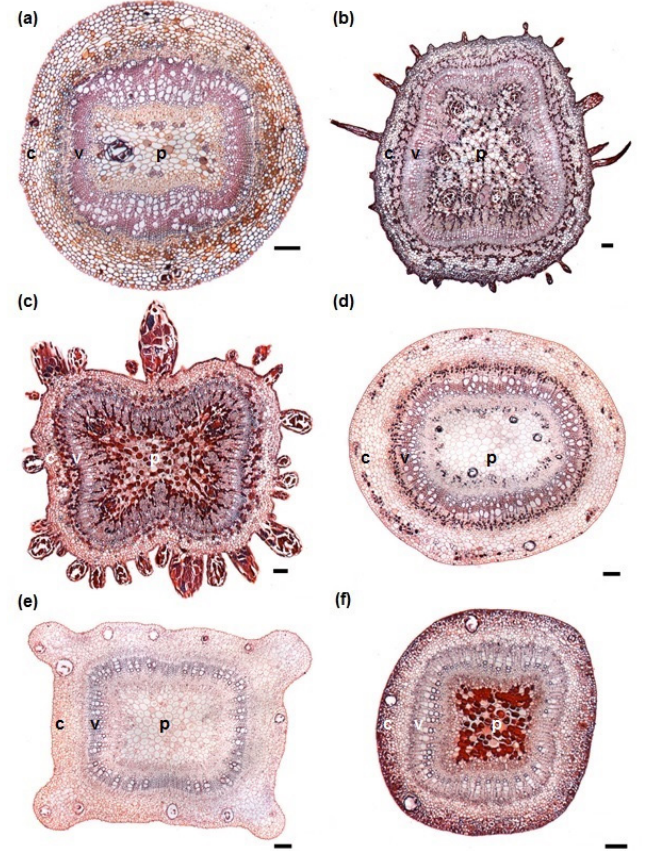
Figure 3. Transverse sections from the stem of cuttings from near the fourth-most apical node (N4) of stock plants of ( a ) Angophora costata , ( b ) Corymbia torelliana , ( c ) C. citriodora , ( d ) Eucalyptus tetrodonta , ( e ) E. microcorys , and ( f ) E. cloeziana . c = cortex; v = vascular tissue; p = pith. Scale bars = 100